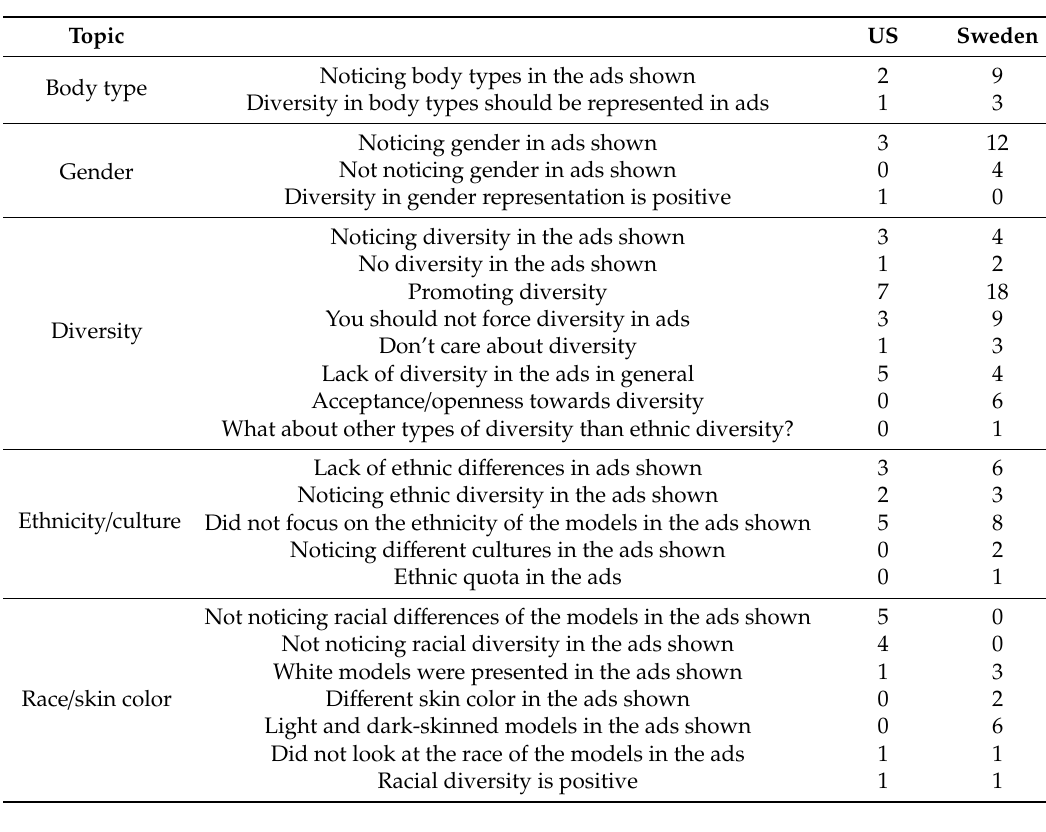
Table 2. Counts on common expression to the open